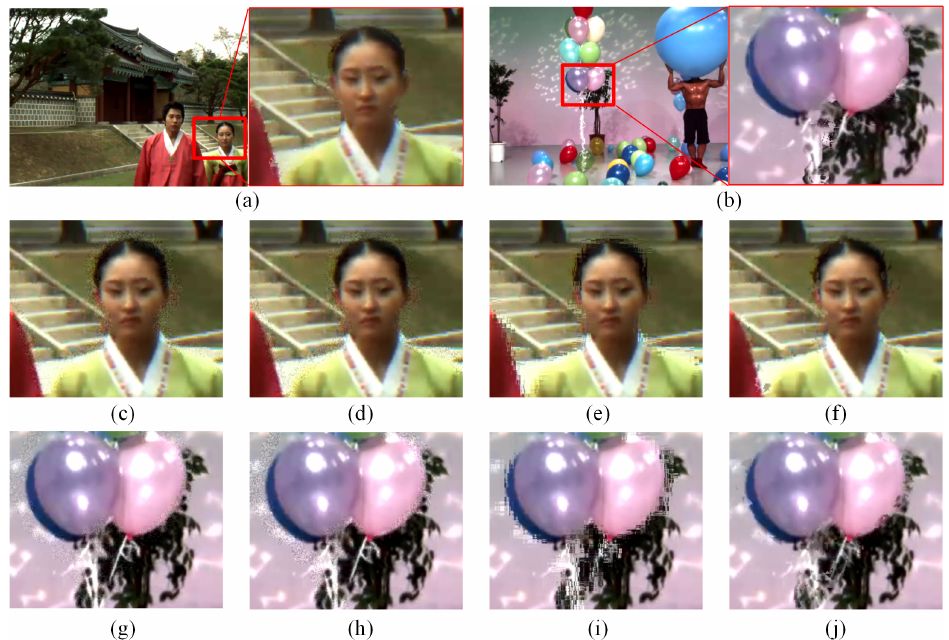
Figure 3. Comparison of DIBR distortion simulation effects by local random noise. ( a , b ) are SVIs from sequences Lovebird1 and Balloons, respectively, and the enlarged areas are the representative areas with both compression and DIBR distortion. ( c – j ) represent the DIBR distortion simulation effects of rectangle areas in ( a , b ) by Gaussian, speckle, patch shuffle-based, and the proposed random irregular polygon-based noise on compressed captured views of Lovebird1 and Balloons,